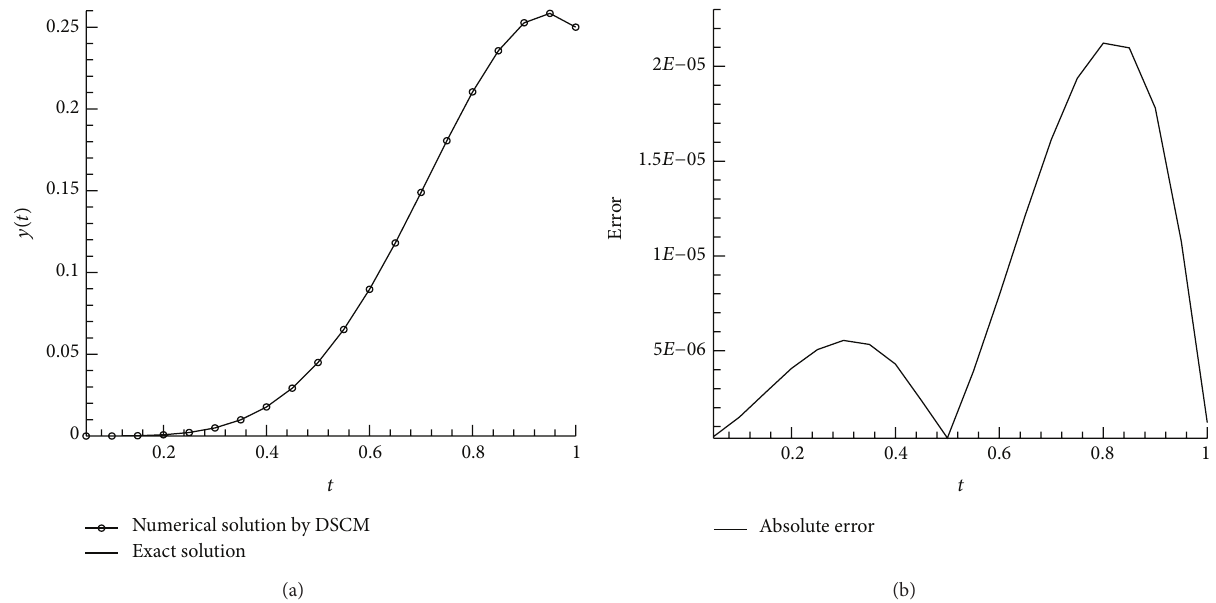
Figure 5: The error between the numerical solutions and the exact solution of the problem (109); 𝛼 = 0.9 , ℎ = 0.05 .